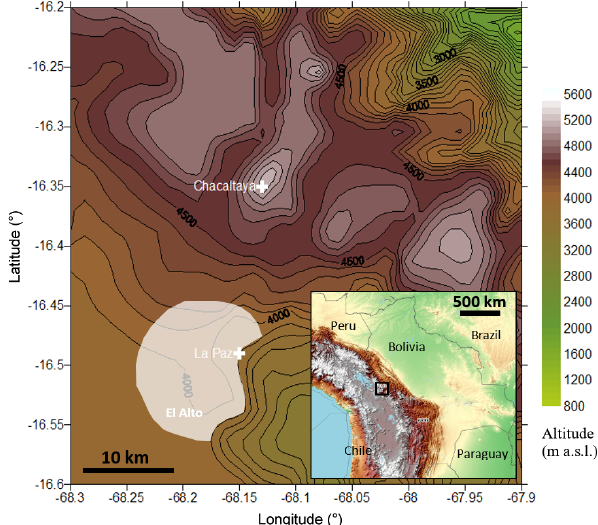
Figure 1. Topographic description of La Paz and Chacaltaya region, and Bolivia in the lower right panel. The black rectangle on the small panel represents La Paz region. The urban area of La Paz– El Alto (marked as white shading) lies in the Altiplano at around 4000ma.s.l.